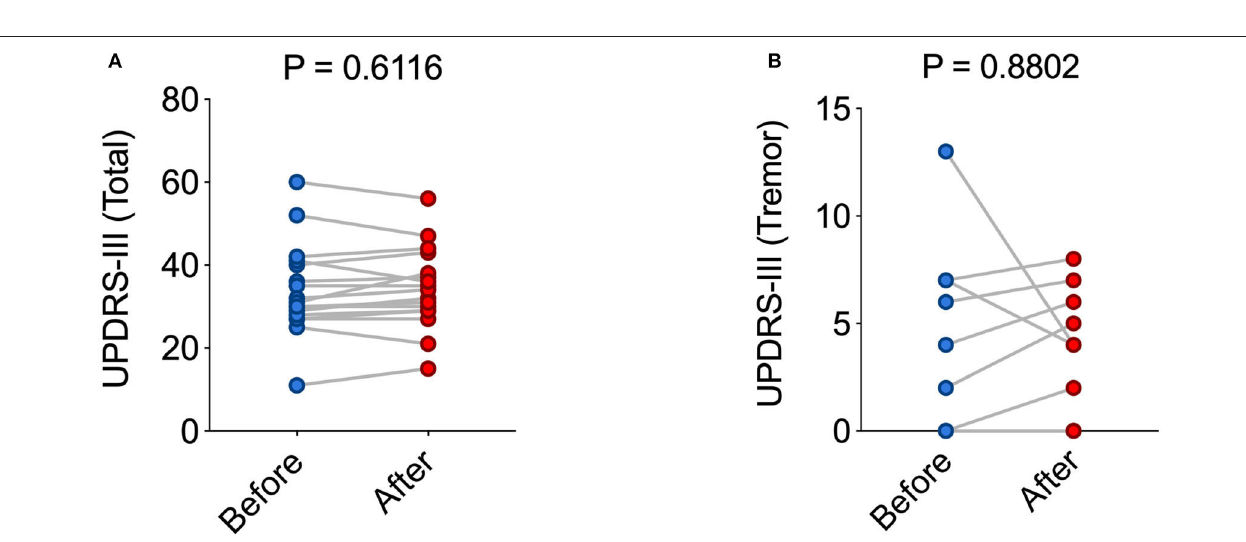
FIGURE 3 | VAS-based programming leads to similar short-term clinical results as compared to standard clinical programming. (A,B) Graphs illustrating the total UPDRS-III value (A) and tremor-selective UPDRS-III value (B) in each individual patient with setting #1 or setting #2 (mean ± s.e.m.: 33.88 ± 2.690 vs. 34.35 ± 2.364; P > 0.05). For statistical comparison, an unpaired t -test has been used in (A,B)